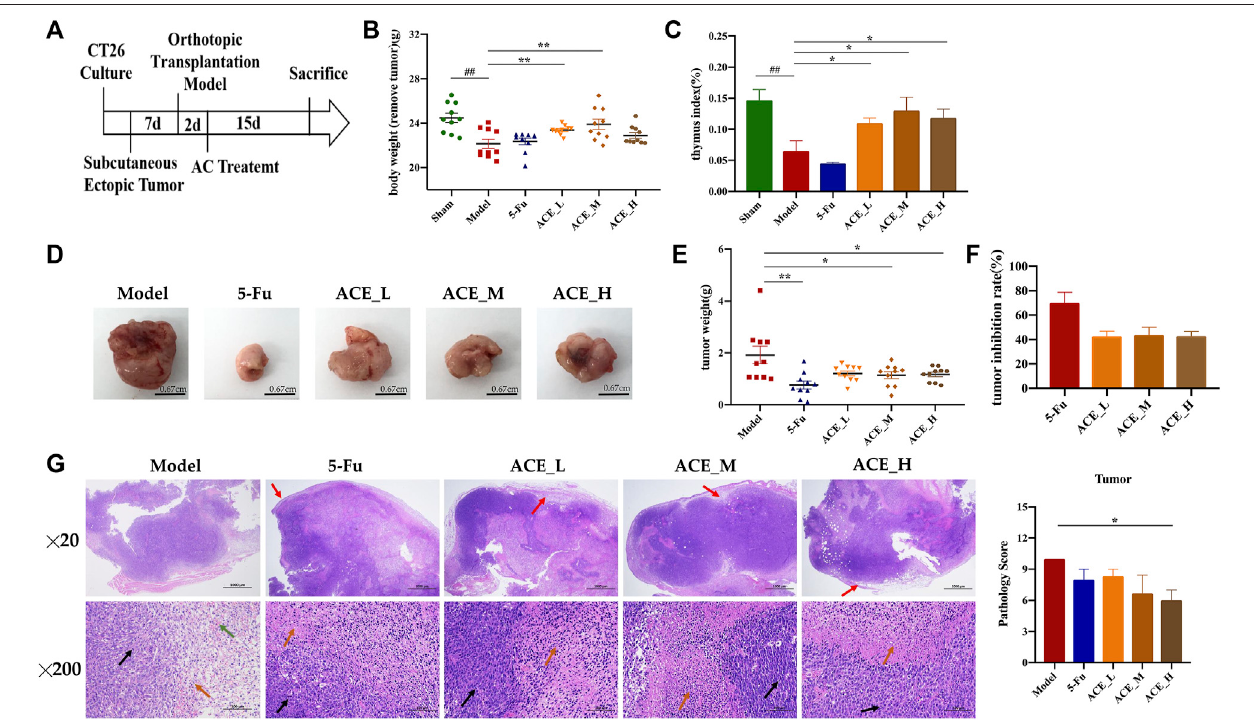
FIGURE 2 | The effect of Astragalus mongholicus Bunge- Curcuma aromatica Salisb. extract on solid tumours of colon cancer-bearing mice. (A) Schematic diagramoftheexperimentaldesignprocess; (B) Bodyweight aftertumourremovalofmiceafter ACEadministration; (C) Thymusindex ofmiceafter ACEadministration; (D) Picturesofsolidtumoursineachgroup; (E) Tumourweight; (F) Tumoursuppressionrate; (G) Tumourhistopathologicalchanges(haematoxylinandeosin(HE)stain). In fl ammatory cells(redarrows),disorderednuclei(blackarrows),haemorrhage withred bloodcells(greenarrows)intumourcells,cytoplasmiceosinophilia(orange arrows). ## p < 0.01, compared with the sham group; * p < 0.05 and ** p < 0.01, compared with the model group. n (cid:2)